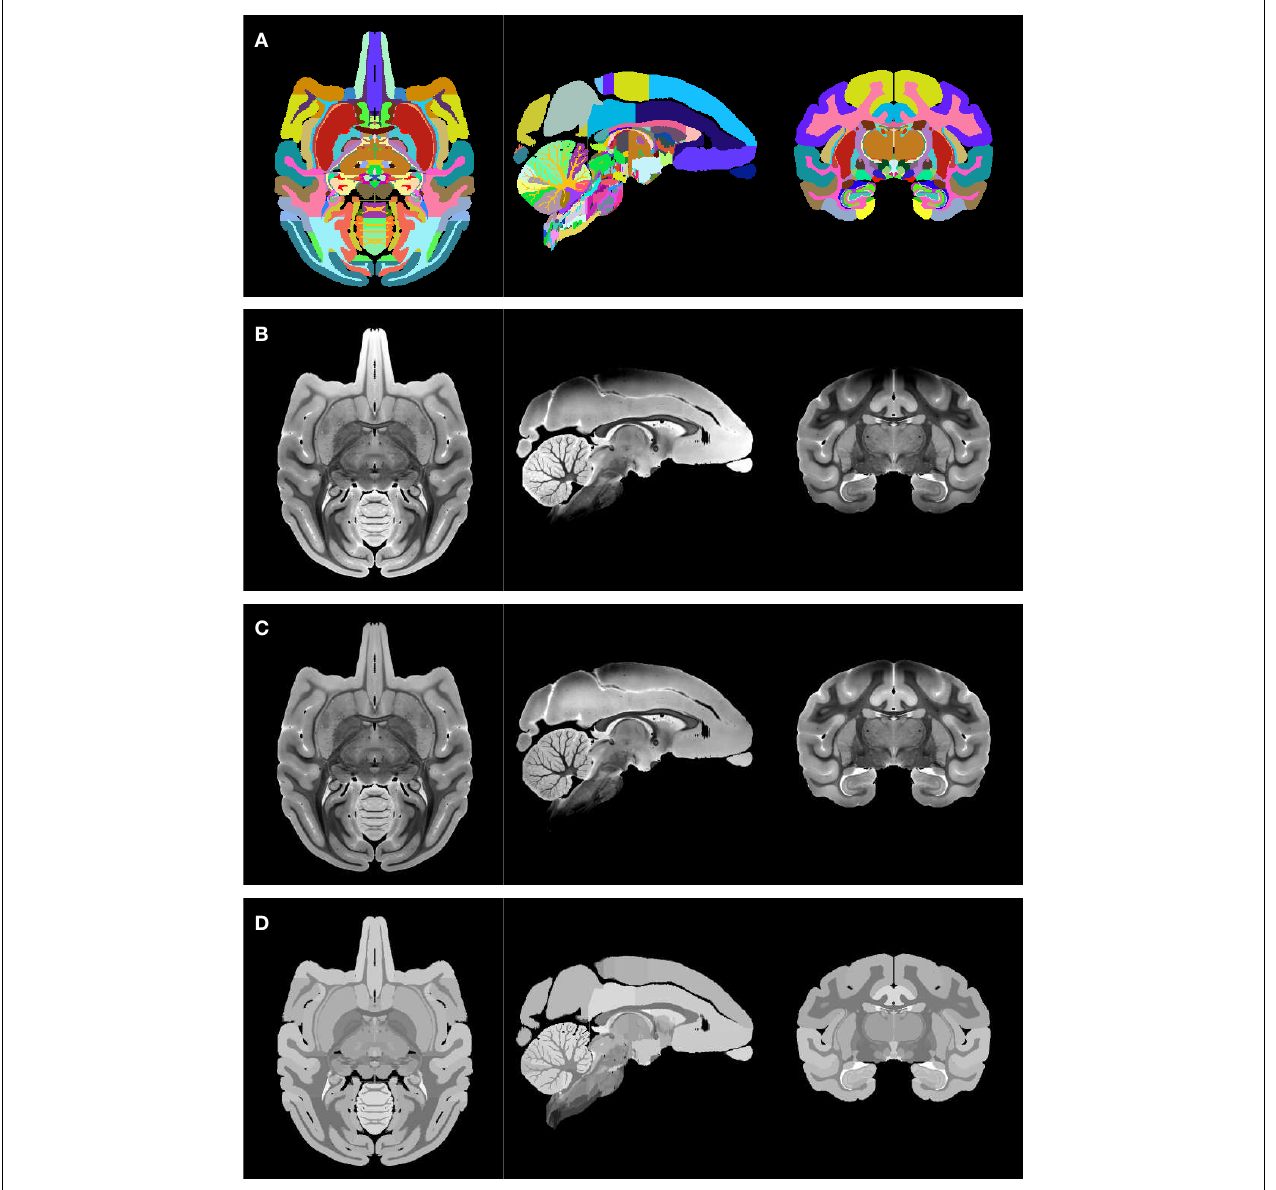
color for simplicity. (B) Symmetric, whole-brain MR image as provided through the NeuroMaps website. (C) Intensity bias-corrected MR image. (D) Region-averaged MR image. See text for